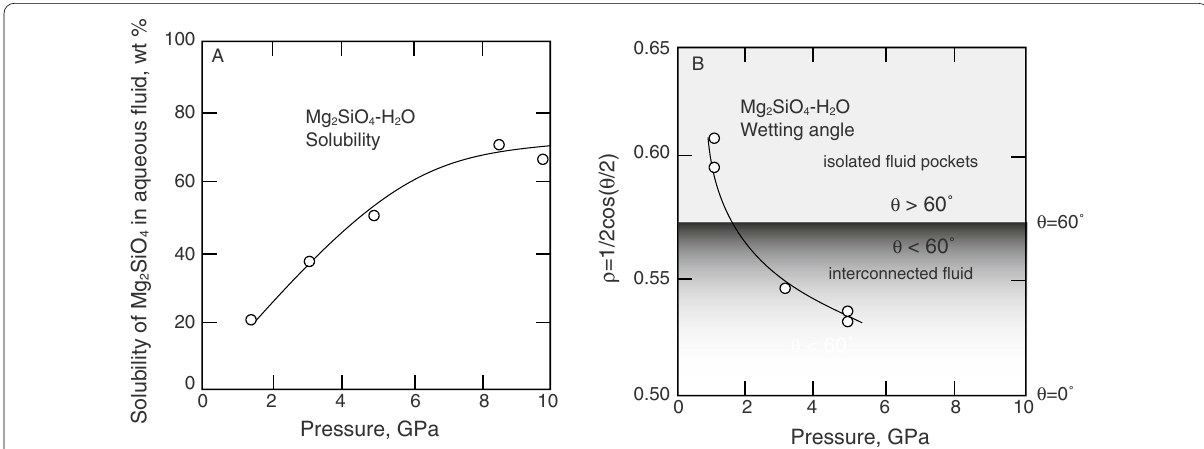
Fig. 34 A . Solubility in aqueous fluid in forsterite–H 2 O system and B . dihedral angle (expressed as the ratio, ρ pressure. Modified from Takei and Shimizu